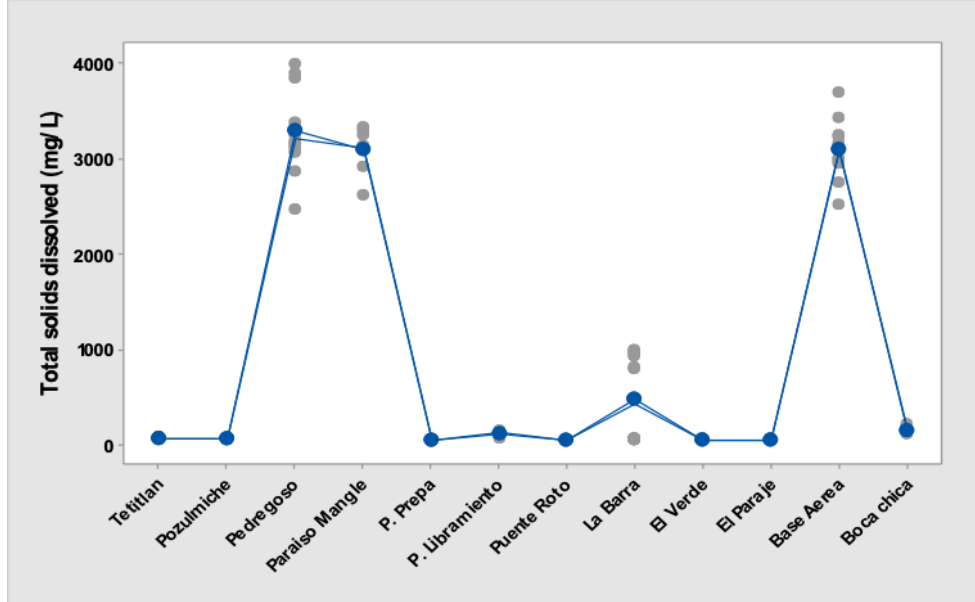
Figure 7. Total dissolved solids values in each location; the grey points refer to the data dispersion in relation to the mean represented by the blue